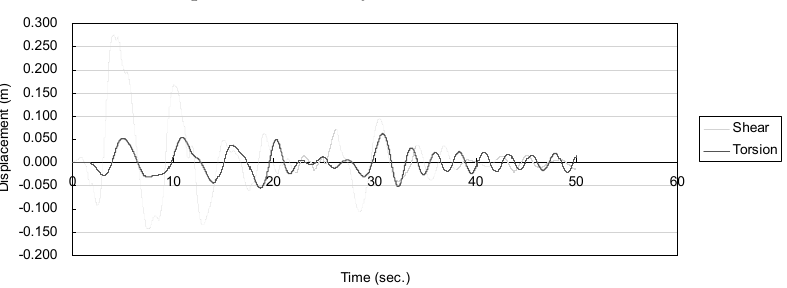
( a ) Lateral displacement in y -direction. ( b ) Rotation. Figure 16. Lateral displacement and rotation history estimated at the center of mass (El Centro, α = 1.3, β = 1.0). The maximum rotations of the 63 time history analysis simulations are plotted with respect to the relative eccentricity ( e x /L) and relative stiffness in the transverse direction ( β ) in Figures 17a and 17b, respectively. It can be noted from Figure 17a that the maximum rotations of all 63 simulations show an increasing trend with increasing relative eccentricity. As already discussed in Section 4.2, β can be regarded as the torsional constraint ratio, and thus Figure 17b clearly indicates that the maximum rotations of the time history analyses decrease as β is increased.